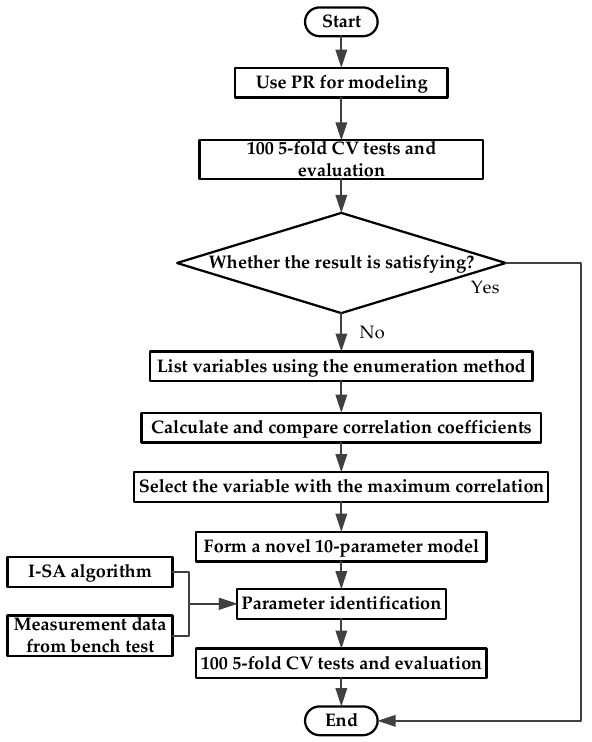
Figure 8. Flow diagram of building method of motor efficiency. Note: PR is Polynomial Regression; CV is Cross Validation; I-SA algorithm is Improved-Simulated Annealing algorithm. Table 4. Related parameters of electric